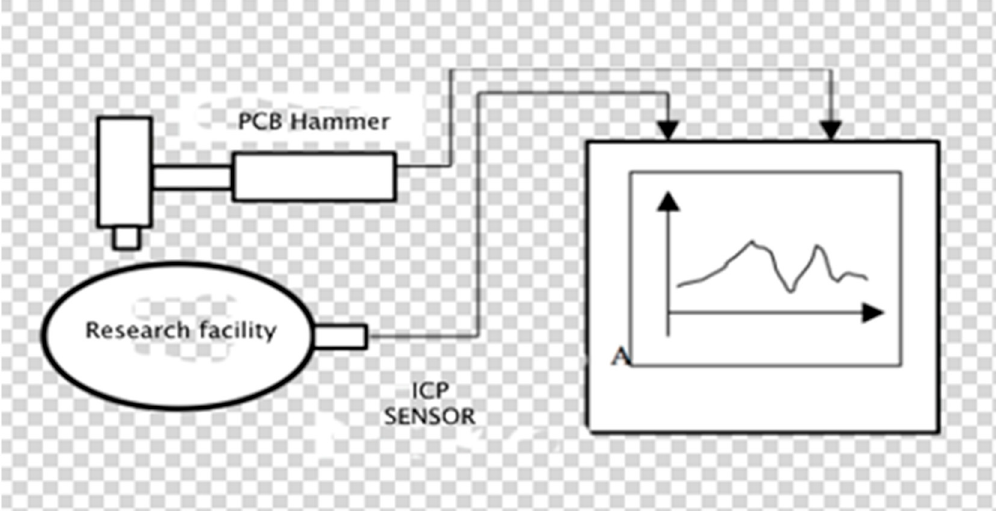
Figure 4. The essence of research in experimental and operational modal analysis.